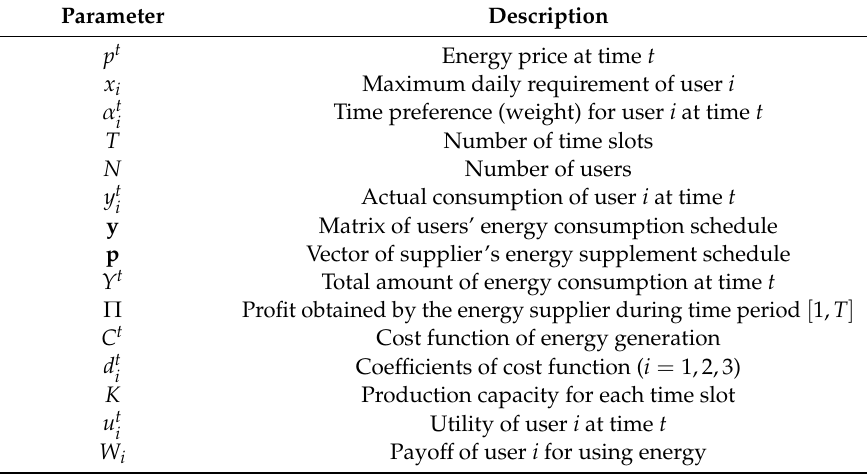
Table 1. Table 1. Notations.